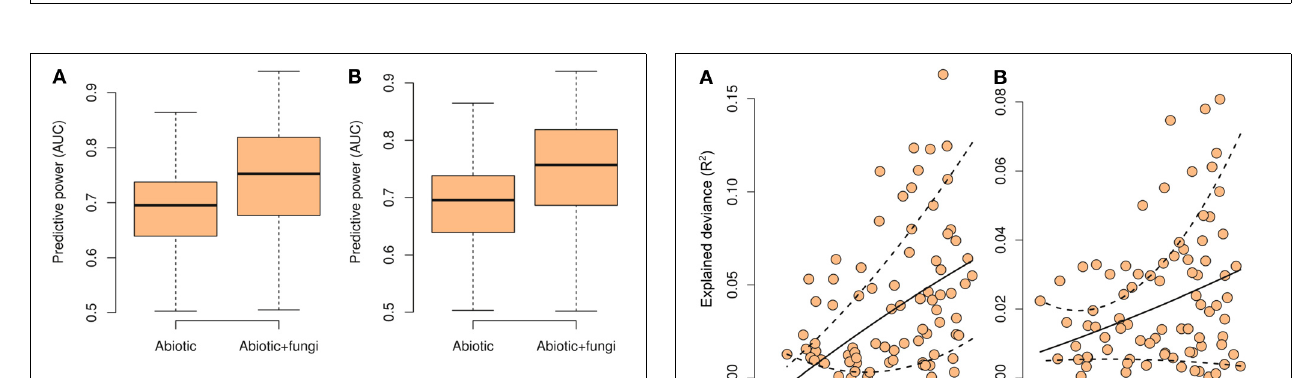
FIGURE 1 | Study area in the Western Swiss Alps (700km 2 ). The gradient from brown to blue represents elevation (400–3210m). The green surface represents forested areas. The dot size corresponds to the number of OTUs per plot of (A) Glomeromycetes and (B) Agaricomycetes in the inventoried plots.